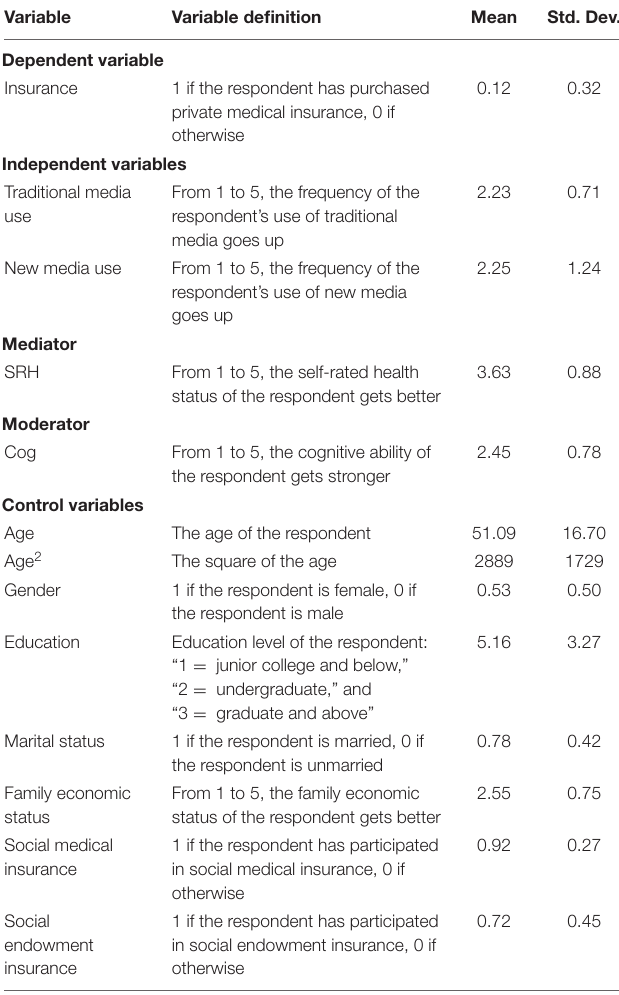
TABLE 1 | Variable definitions and descriptive statistics ( N =